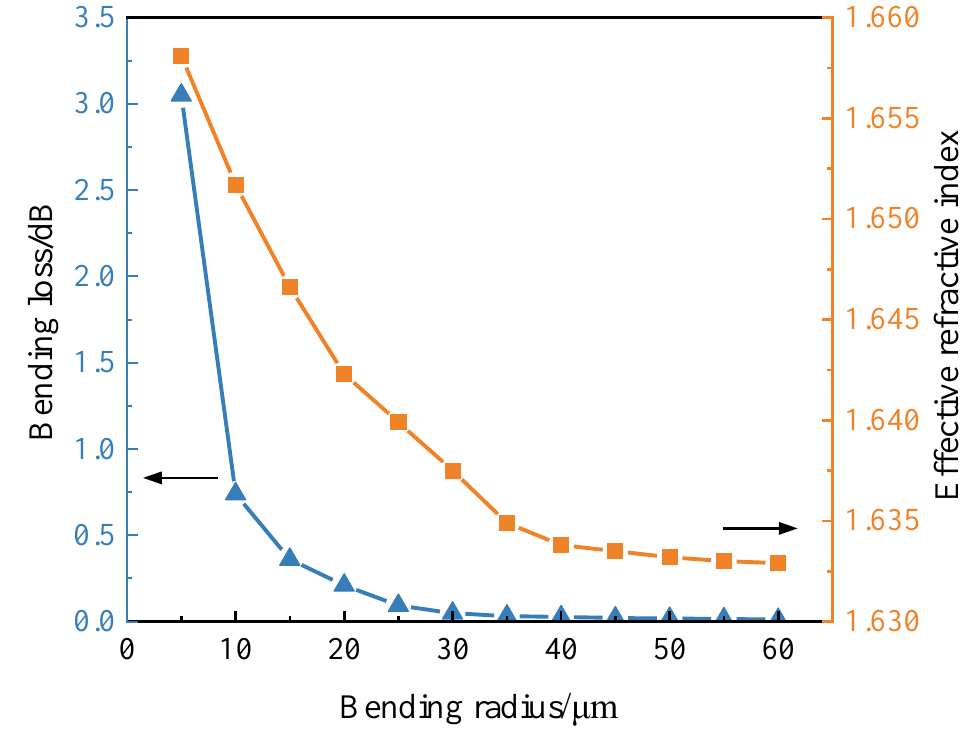
Figure 2. Relationship among effective refractive index, bending loss, and bending radius of 1 μm wide and 400 nm thick silicon nitride waveguide. The simulated results of different bending radii of the bent DC and the conventional